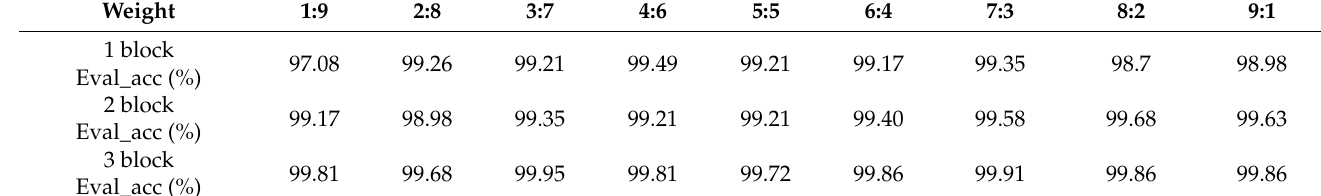
Table 6. Experimental results under different weight ratios of a single block and multiple blocks.